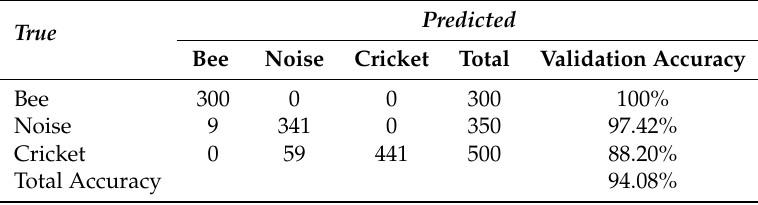
Table A4. Confusion matrix for RawConvNet with receptive field size n = 30 on BUZZ1 validation dataset.